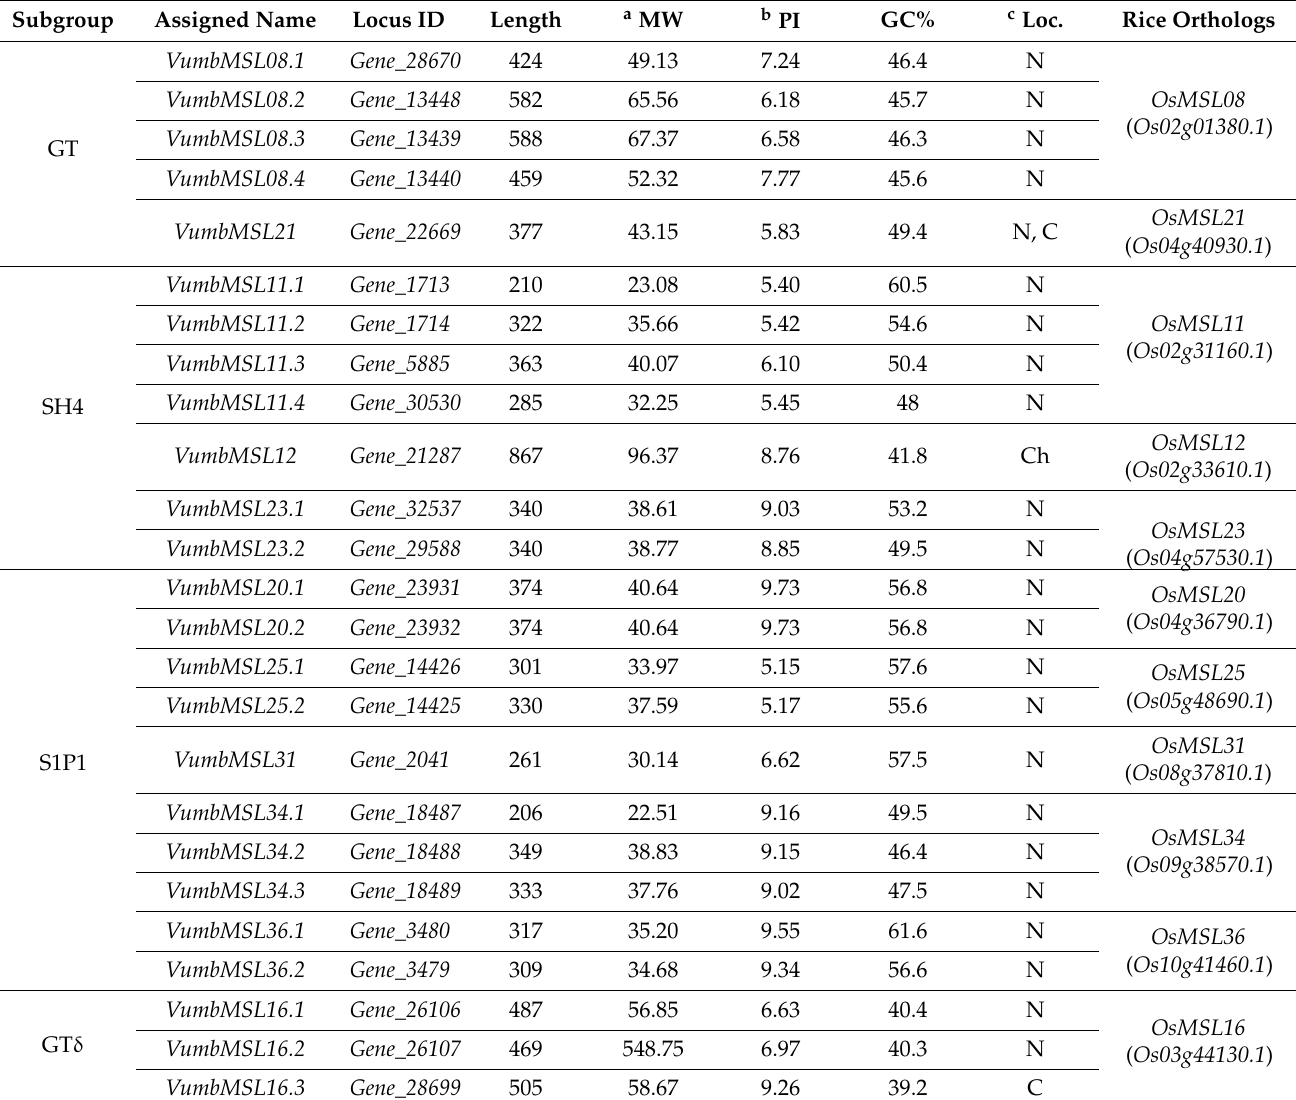
Table 4. Basic Characteristics of Vigna umbellata Trihelix